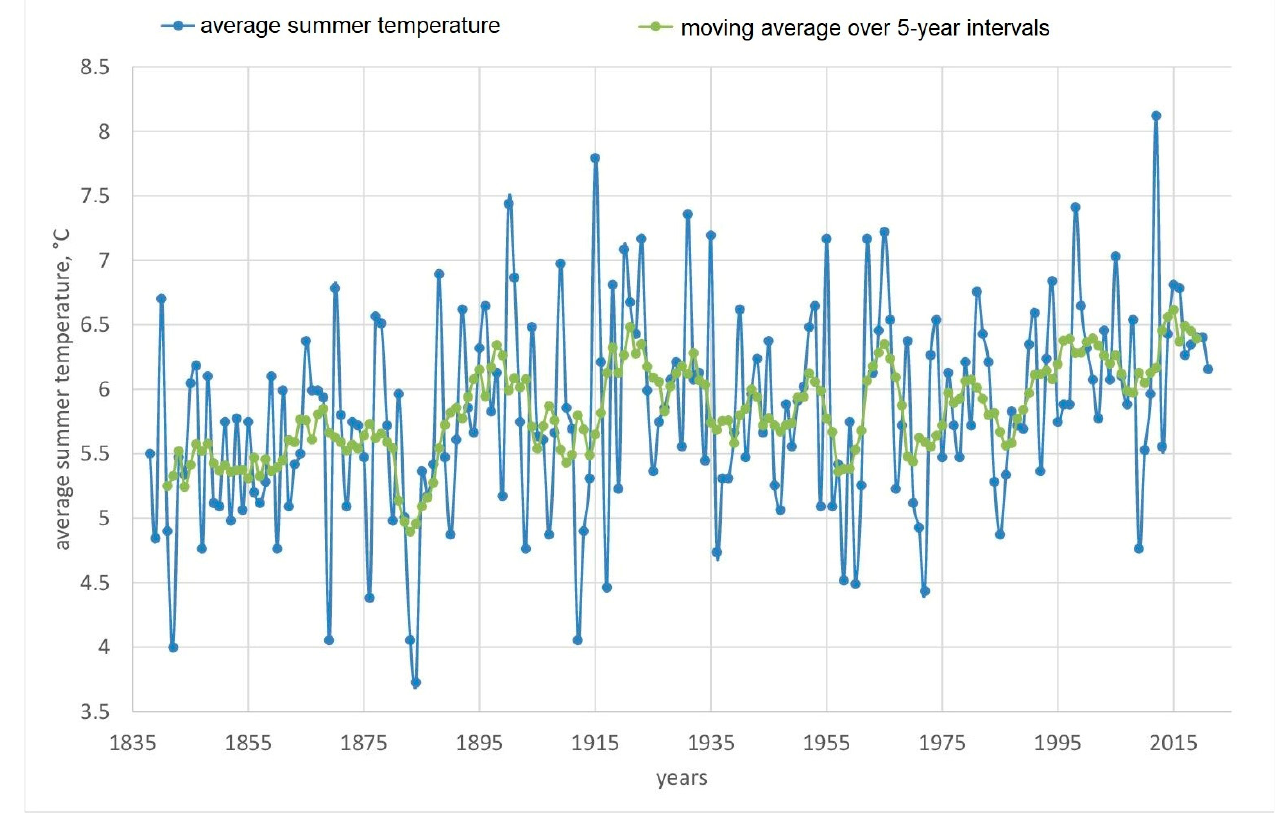
Figure 13. Changes in the average summer temperature at the Kara-Turek meteorological station; the series is extended to 1835 based on data from the Barnaul meteorological station.